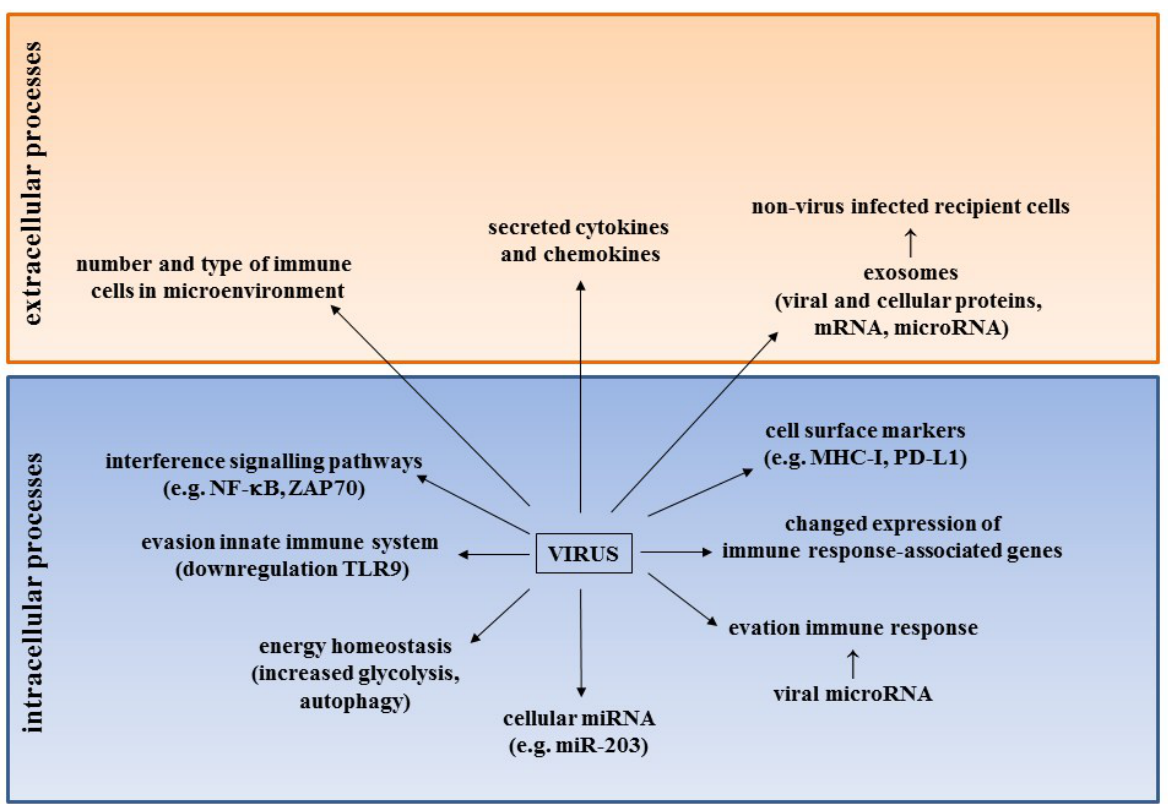
Figure 1. Novel mechanisms by which HPyV may contribute to cancer. See text and Table 2 for